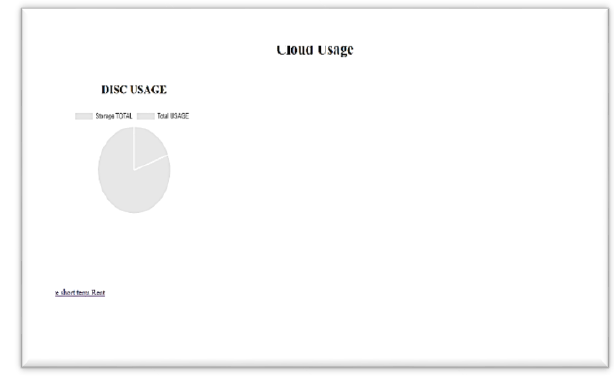
Figure 9. Disk Utilization